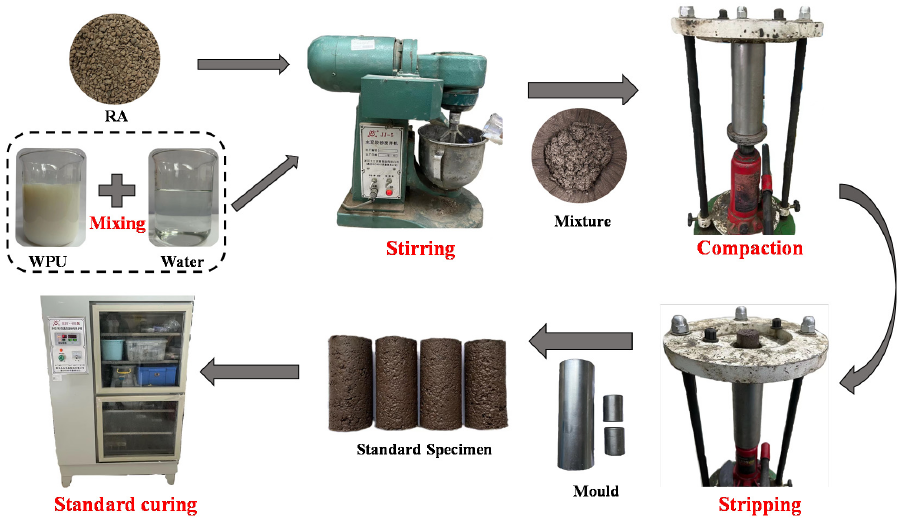
Figure 3. Specimen preparation process.